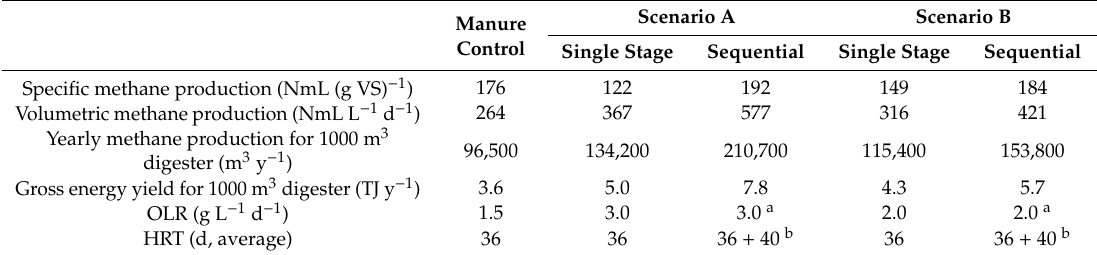
Table 5. Biogas production parameters for the two